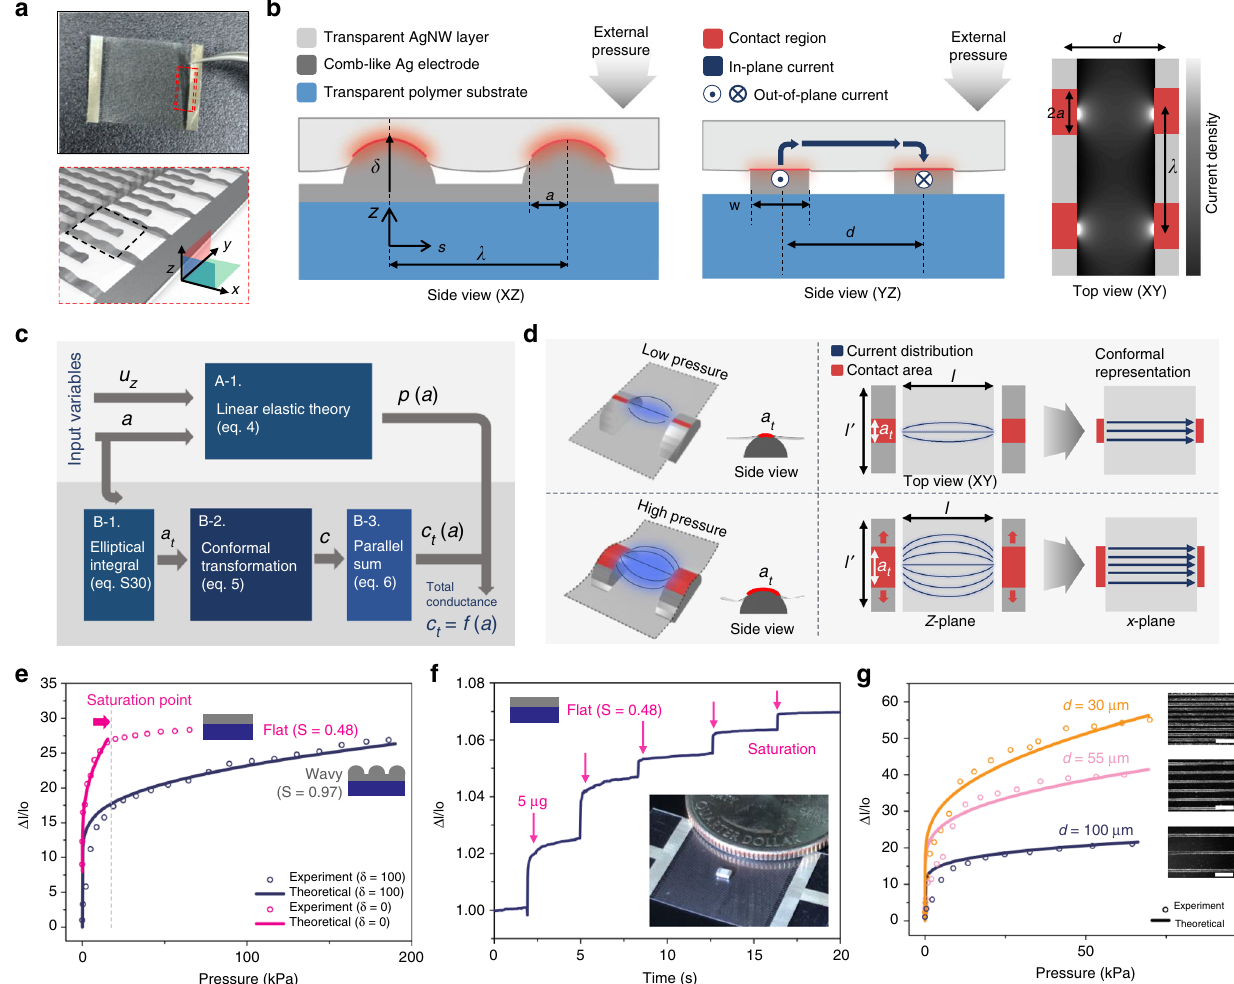
Fig. 3 Theoretical analysis of the sensor. a Picture of free-standing lower comb-like electrode with magni fi ed image in which the black dashed box denotes the control surface. b Illustration of electro-mechanical phenomenon with respect to the three different views in the control surface. XZ plane side view (left), YZ plane side view (center), and XY plane top view (right). XY top view containing simulation image of current distribution over the AgNW layer. c Diagram of the theoretical analysis. d Schematics of the adjusted current distribution according to different external pressure and contact area. Right side denotes the conformal representation of the equipotential line. e Current change for different surface morphology and comparison between the theoretical data from Eqs. (4) and (6). f Demonstration as a high sensitive sensor ( fl at morphology, S = 0.48). g Output signal distribution as a function of